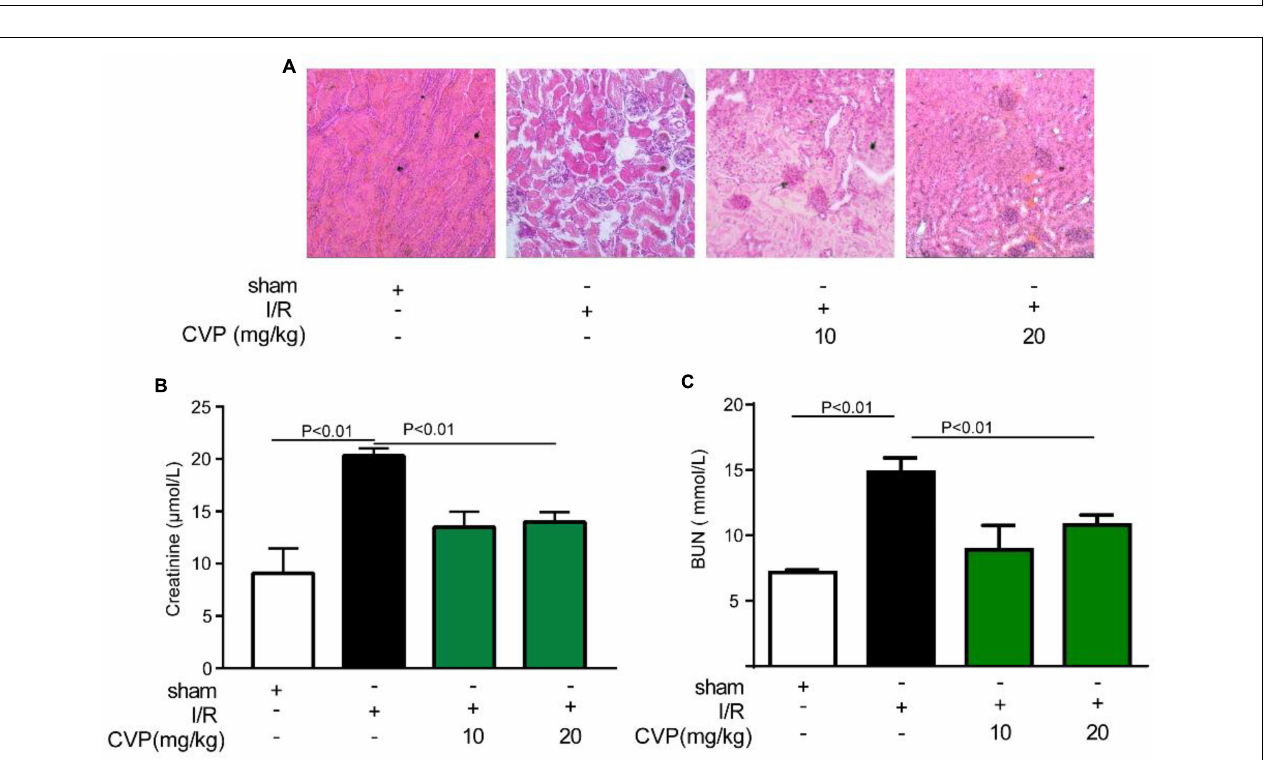
FIGURE 5 | The effect of CVP on acute renal injury secondary to I/R injury. After the kidney was isolated, morphological alterations of the kidneys were examined via H&E staining ( × 10) (A) ; the renal function was assessed by detecting the levels of blood creatinine (B) and BUN (C) . BUN, blood urea nitrogen; CVP, Chuanminshen violaceumis polysaccharides; I/R, ischemia-reperfusion.